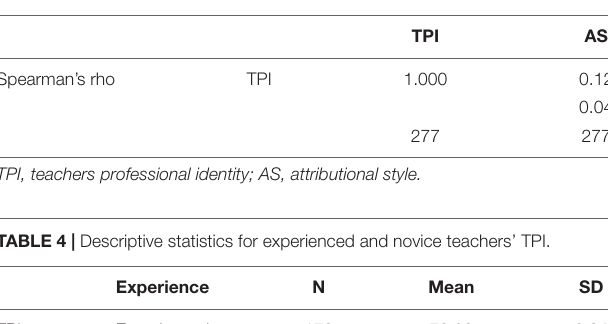
TABLE 3 | Spearman rho Correlation for AS and TPI.